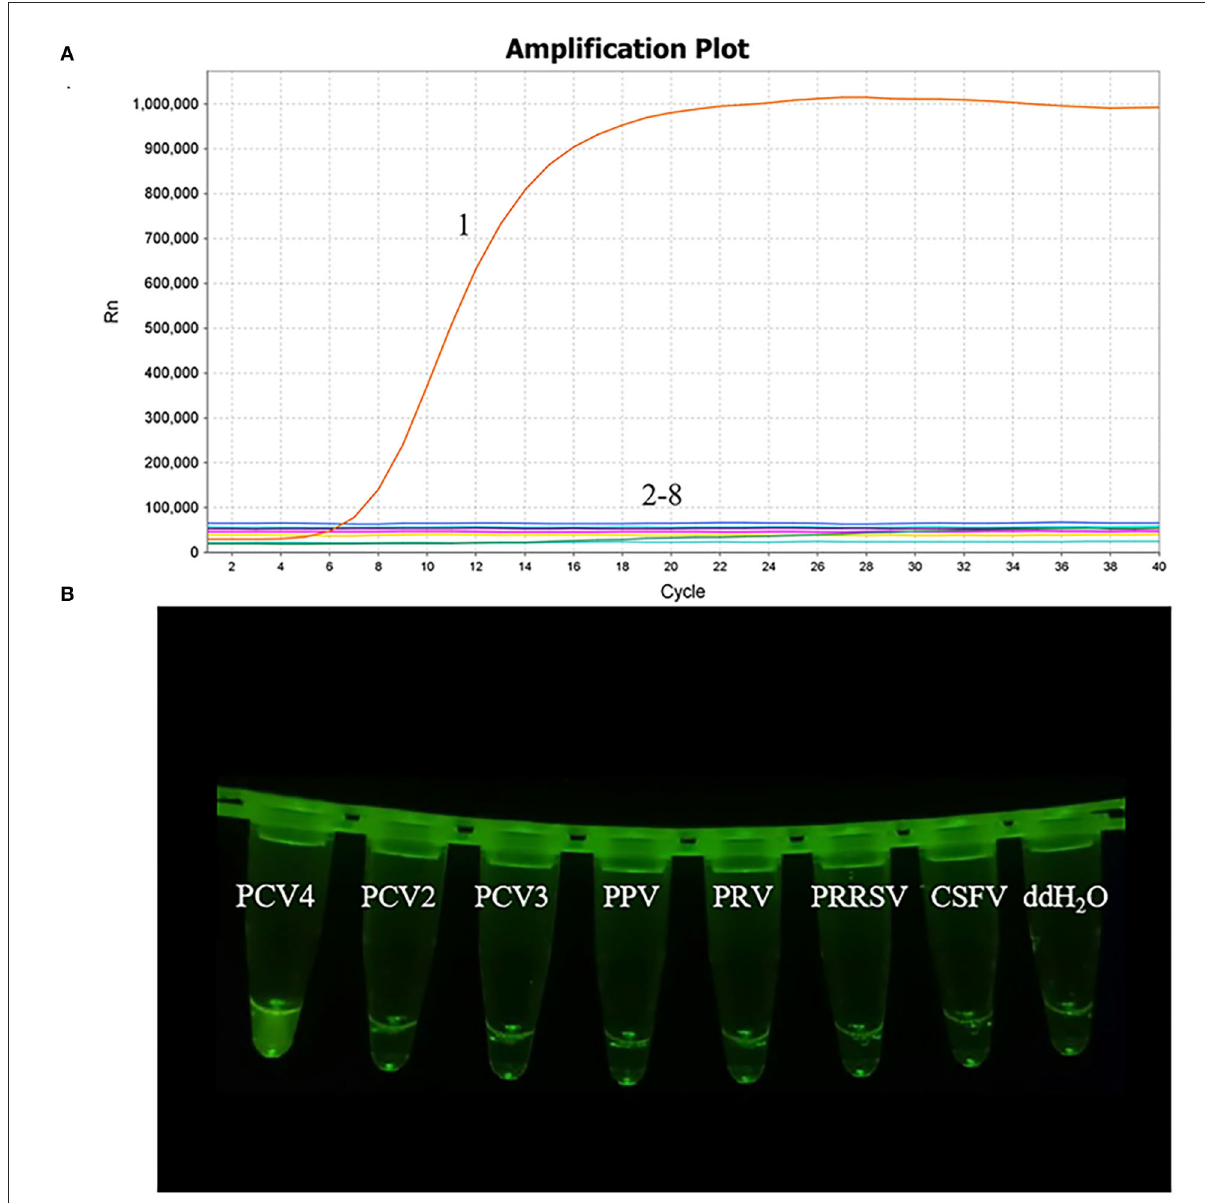
FIGURE4 Analytical specificity result of the MIRA assay. (A) The amplification results of MIRA in the form of fluorescence read-out. 1, PCV4; 2, PCV2; 3, PCV3; 4, Porcine parvovirus (PPV); 5, Pseudorabies virus strain HB-98 (PRV); 6, the vaccine strains of Porcine reproductive and respiratory syndrome virus strain R98 (PRRSV); 7, Classical swine fever virus strain AV1412 (CSFV); 8, RNase-free ddH 2 O. (B) Direct visual observation under UV light of the amplification products of MIRA. Tubes, from left to right, nucleic acid templates corresponding to PCV4, PCV2, PCV3, PPV, PRV, PRRSV, CSFV and negative control of RNase-free ddH 2 O,